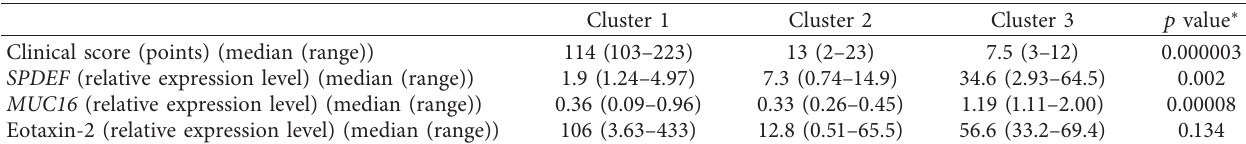
Figure 5: Dendrogram of cluster analysis in patients with chronic allergic conjunctival diseases (ACDs). Each of the 19 patients with chronic ACDs were given a code from AA to AS. The active group included those from AA to AI, whereas the stable ACD group included those from AJ to AS. The dendrogram depicts the levels of the hierarchical cluster. Table 3: Characteristics of three cluster groups of allergic conjunctival disease